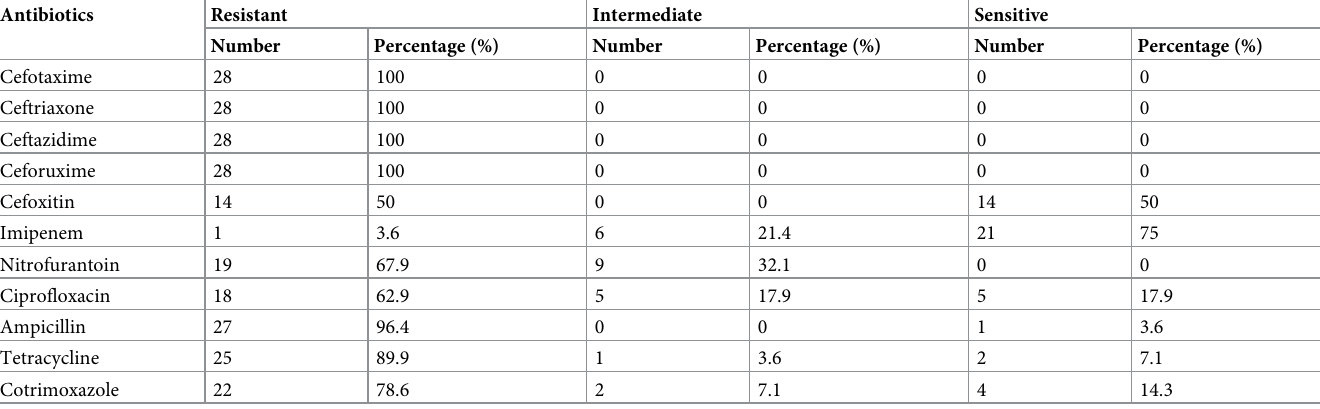
Table 4. ESBL producing Enterobacteriaceae resistant pattern to antibiotics among food handlers. Antibiotics